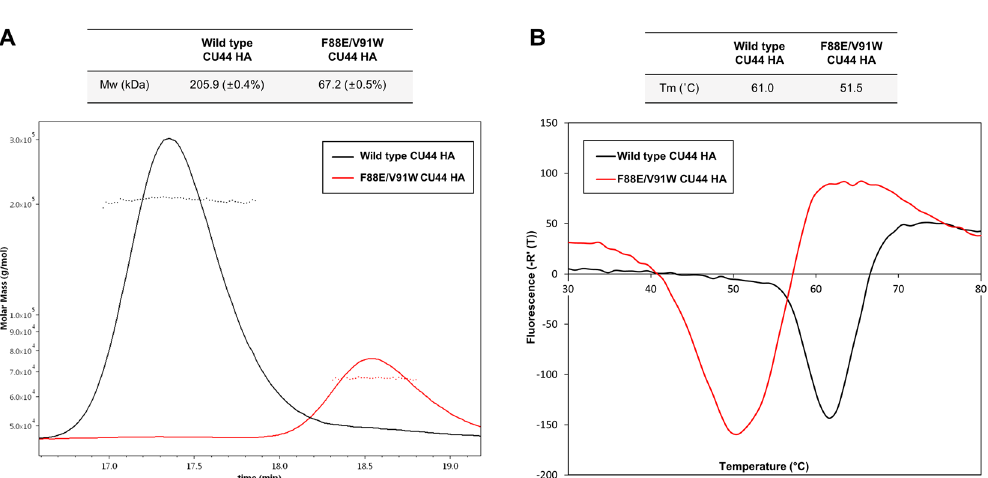
Figure 2. Characterization of HA mutant protein. ( A ) SEC-MALS analysis of the purified double mutant. The molecular masses of the CU44 wild-type and double mutant HA proteins agreed with the value of 67.2 kDa and 205.9 kDa, respectively, taking into account glycosylation. The flow rate in SEC-MALS was 0.5 ml/min using a UFLC system. ( B ) Differential scanning fluorimetry transition curves of the wild-type HA trimer (in black) and double mutant monomer (in red). Each HA protein was incubated at 25 °C for 30 sec, and then the temperature was increased by 0.5 °C every 30 sec for 50